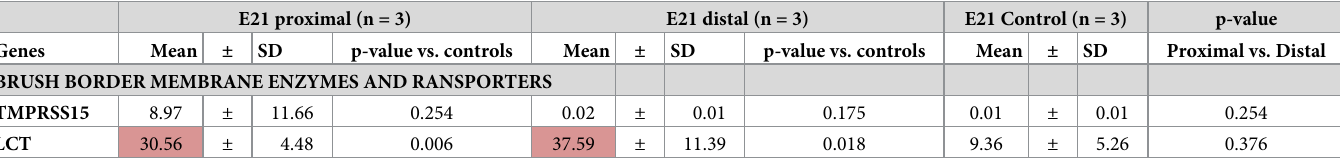
Table 4. Quantitative real-time PCR results: Gene expression and p-values of selected brush-border membrane enzymes and transporters. E21 proximal (n = 3) E21 distal (n = 3) E21 Control (n = 3) p-value Genes Mean ± SD p-value vs. controls Mean ± SD p-value vs. controls Mean ± SD Proximal vs. Distal